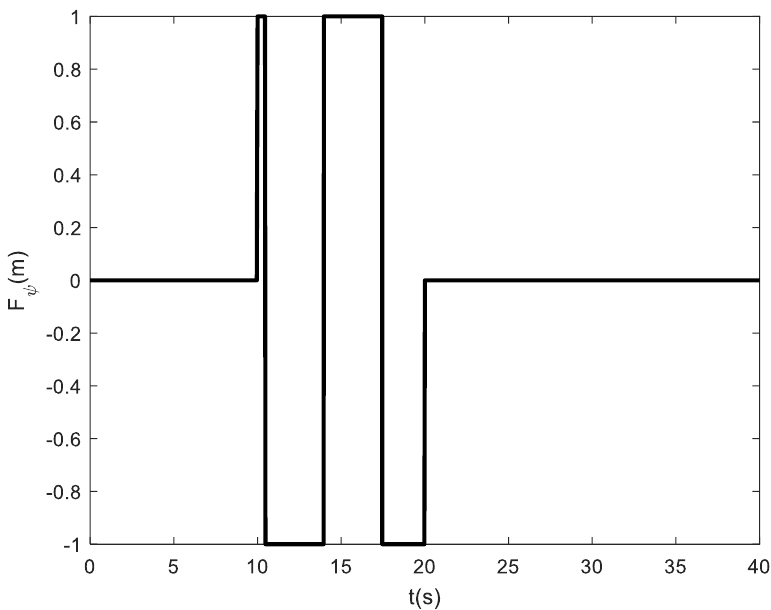
Figure 5. The curve of the disturbance in position Z channel.